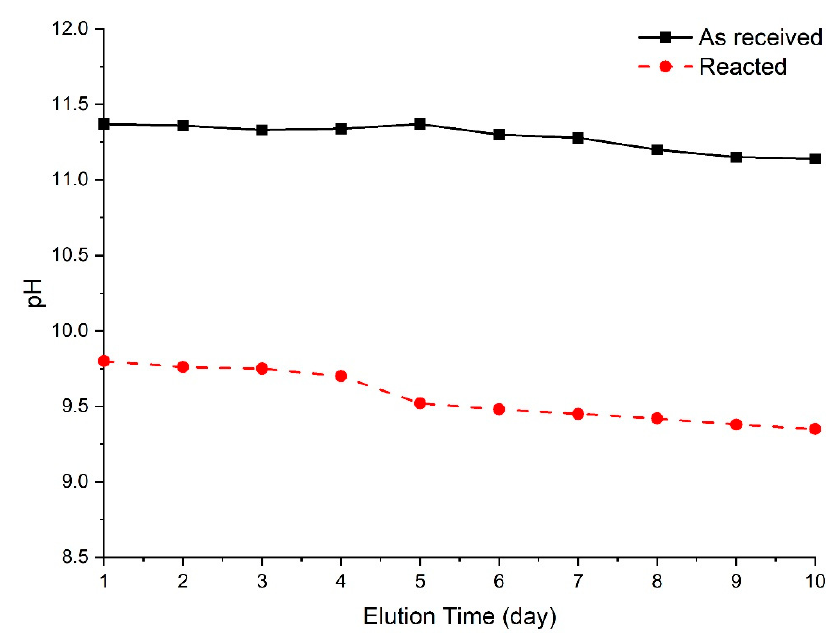
Figure 5. pH of converter slag reacted with supercritical carbon dioxide.